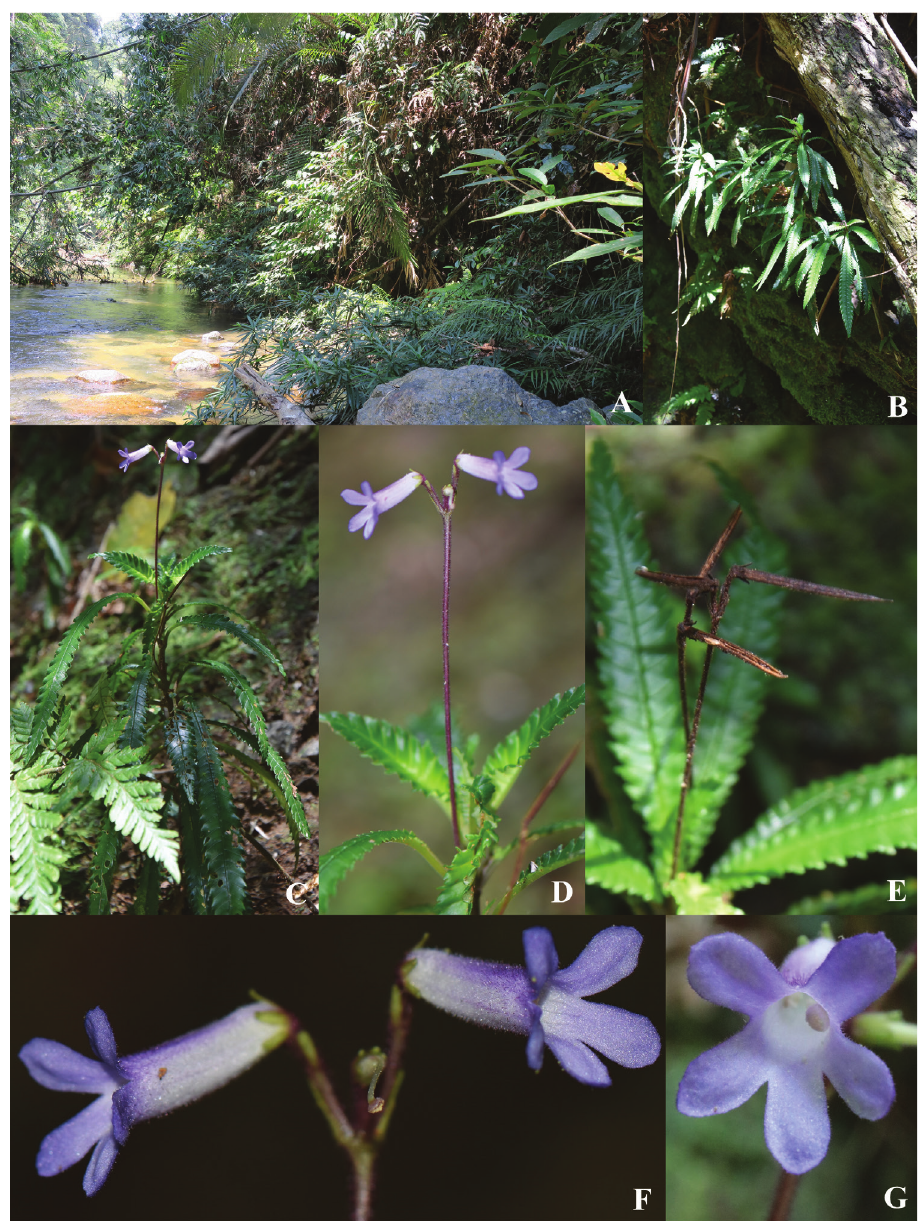
Figure 2. Codonoboea kenaboiensis Syahida-Emiza, Y.Y.Sam & Siti-Munirah, sp. nov. A, B habitat C, D habit e fruits F flowers G corolla lobes (front